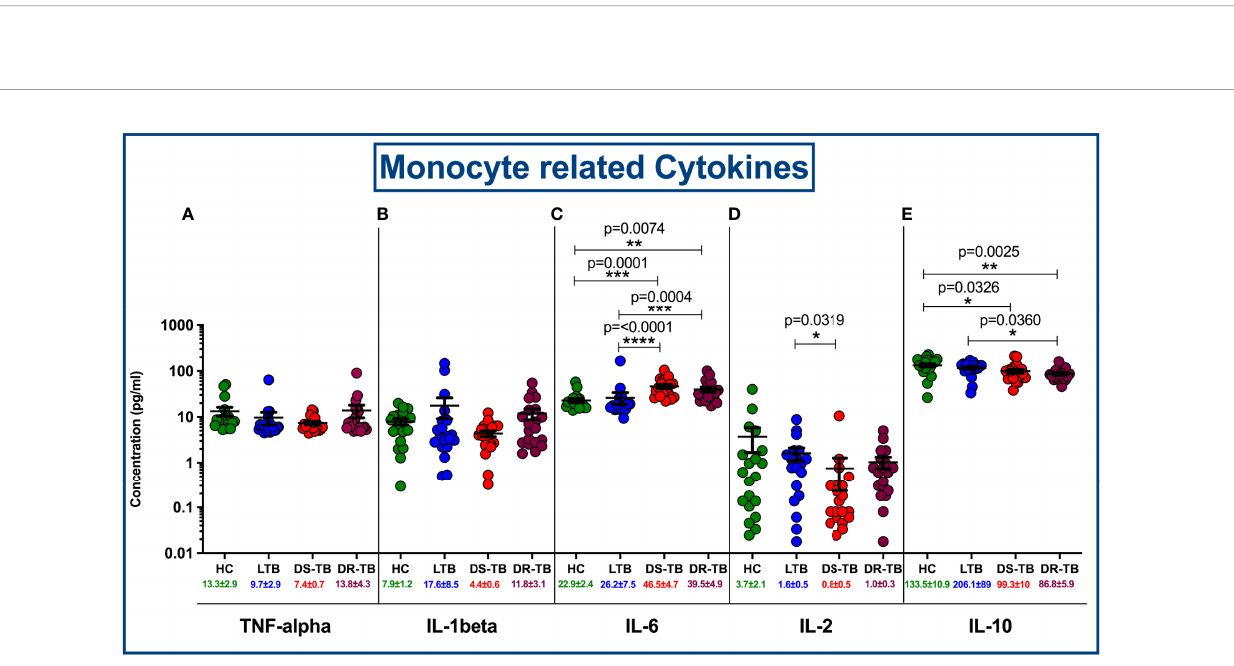
FIGURE 8 | Comparison of mean concentration of circulating pro and anti-in fl ammatory cytokines, TNF- a (A) , IL-1 b (B) , IL-6 (C) , IL-2 (D) and IL-10 (E) among four groups. p value less than 0.05 is considered as statistically signi fi cant and the level of signi fi cance denoted as * [p<0.01(*); p<0.001(**); and p<0.0001(***)]. The signi fi cance level with their p values are mentioned in the graph. Highly signi fi cant ones are mentioned as **** where p=<0.0001.